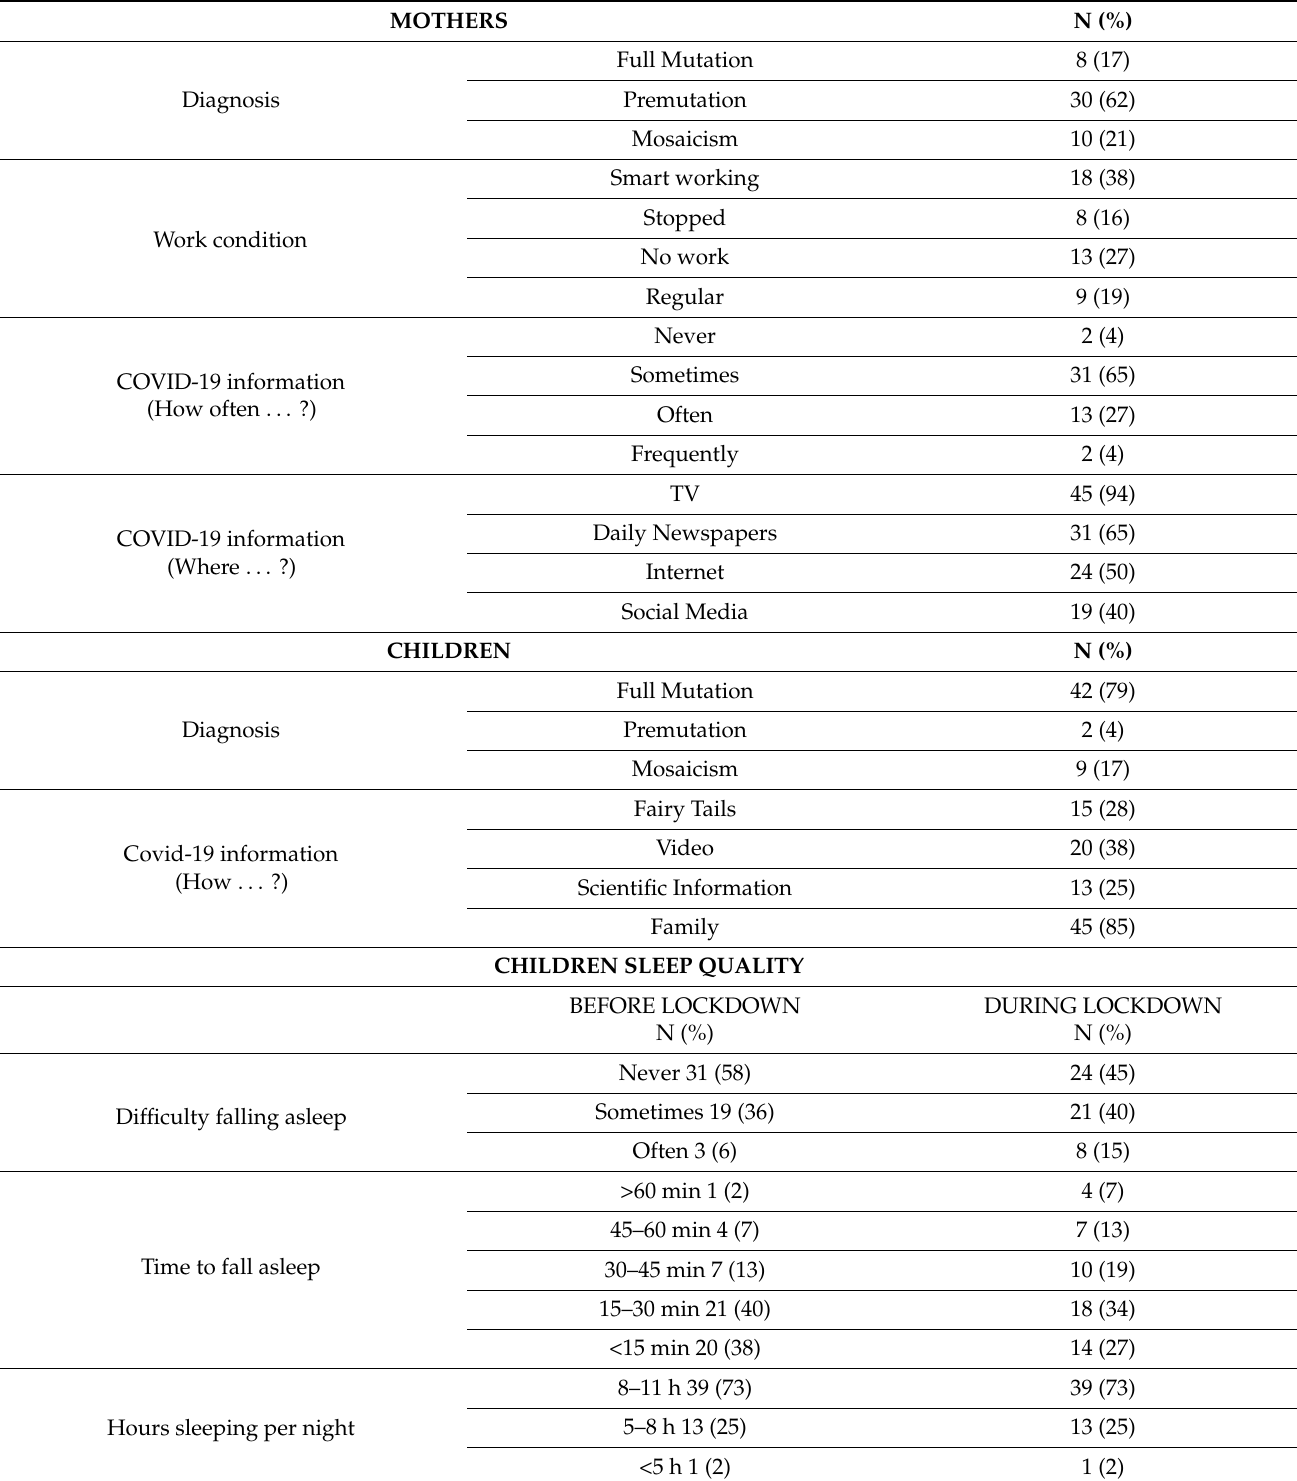
Table 1. Demographics, children’s sleep quality and daily